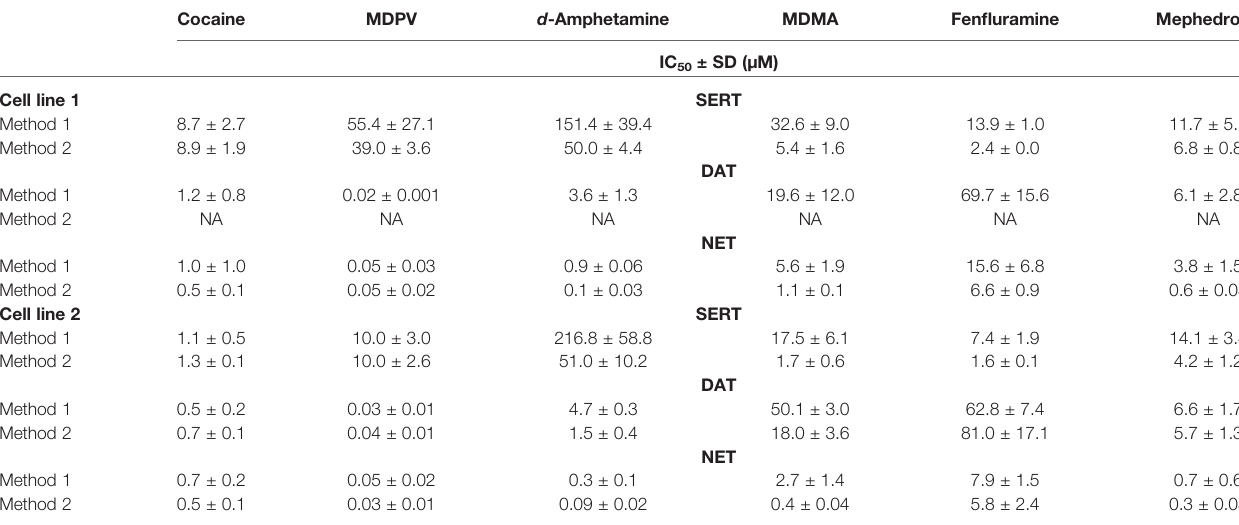
TABLE 2 | Comparison of two uptake inhibition methods in different HEK 293 cell lines stably expressing human MATs.